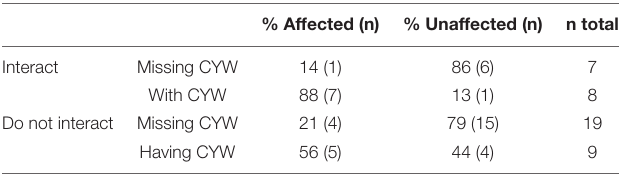
Results based on Supplementary Figure S8 and Supplementary Table S2